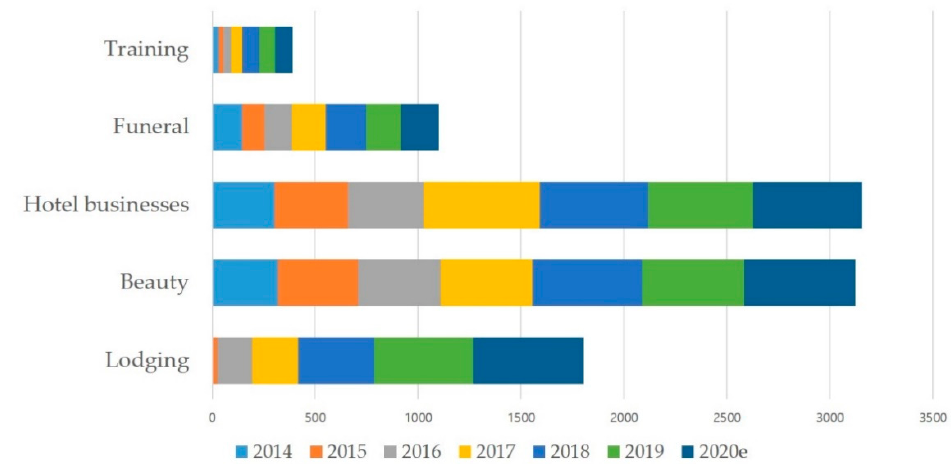
Figure 3. Number of applications by business type related to companion animals.